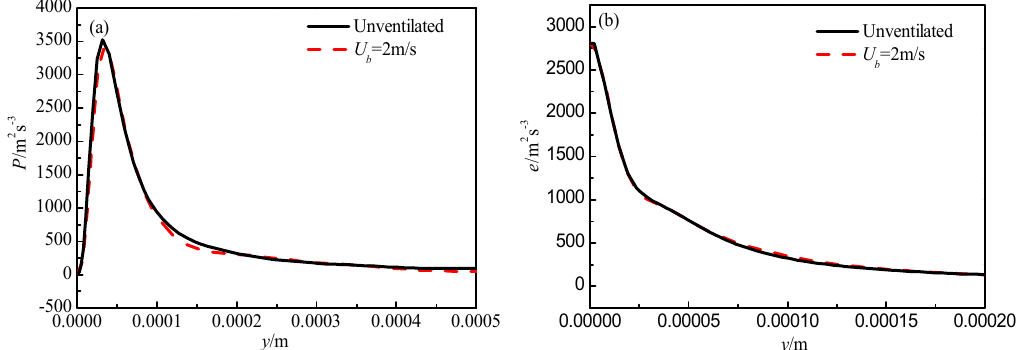
Figure 18. Average distribution of production and dissipation of turbulent kinetic energy along the normal direction: ( a ) production of turbulent kinetic energy and ( b ) dissipation of turbulent kinetic energy.